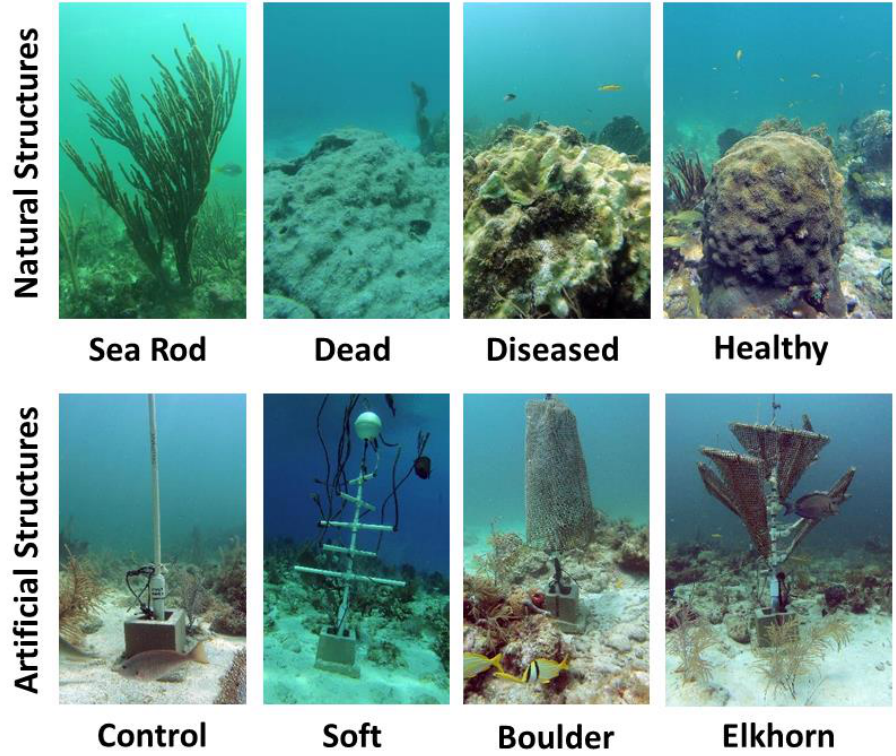
Figure 2. Reef fishes’ use of structures was monitored on natural and artificial structures. Natural structures ( top ) included sea rods, and dead, actively diseased, and healthy boulder corals. Artificial structures ( bottom ) included a control and three structures that were built to mimic historically abundant natural structures including soft coral, boulder coral, and branching coral (elkhorn coral, Acropora palmata ).